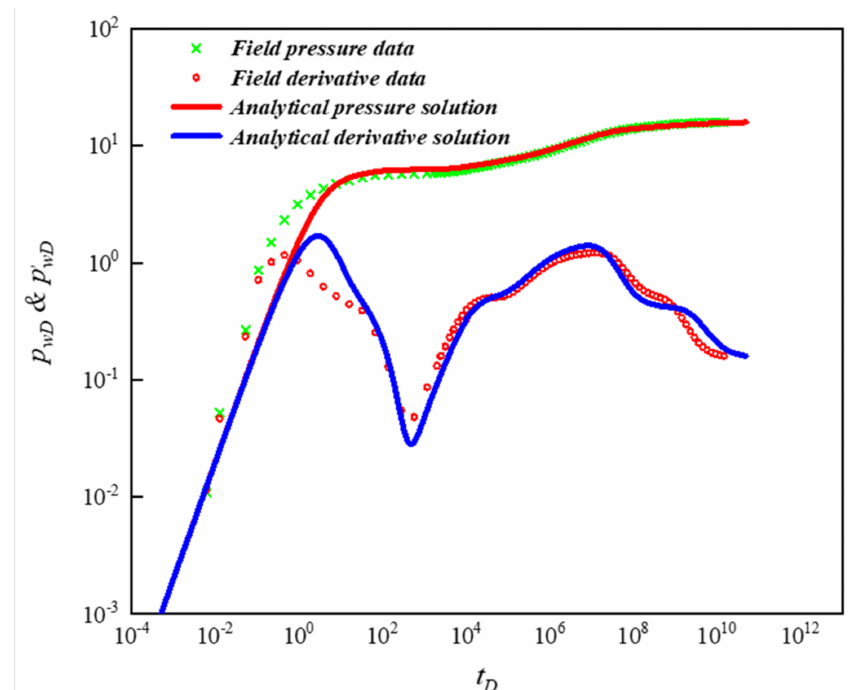
Figure 7. The application of the proposed analytical